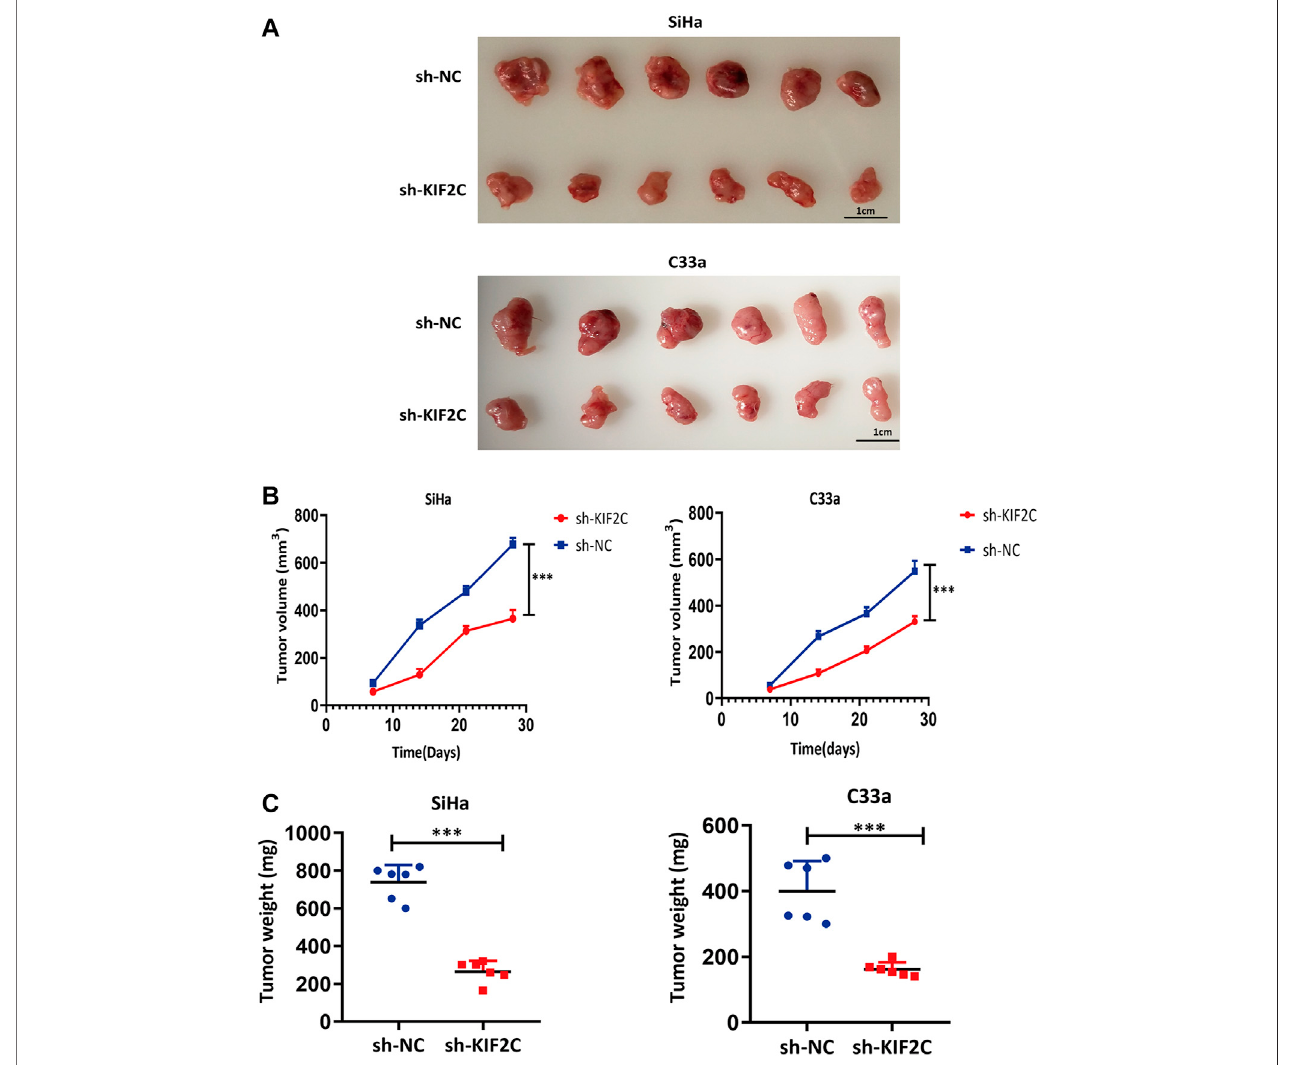
FIGURE12| KIF2C knockdown suppressed tumor growth invivo . (A) Photosoftumor samplesfrommice; (B) curve oftumor volume inmice; (C) scatter graphof tumor weight. ***p < 0.001.